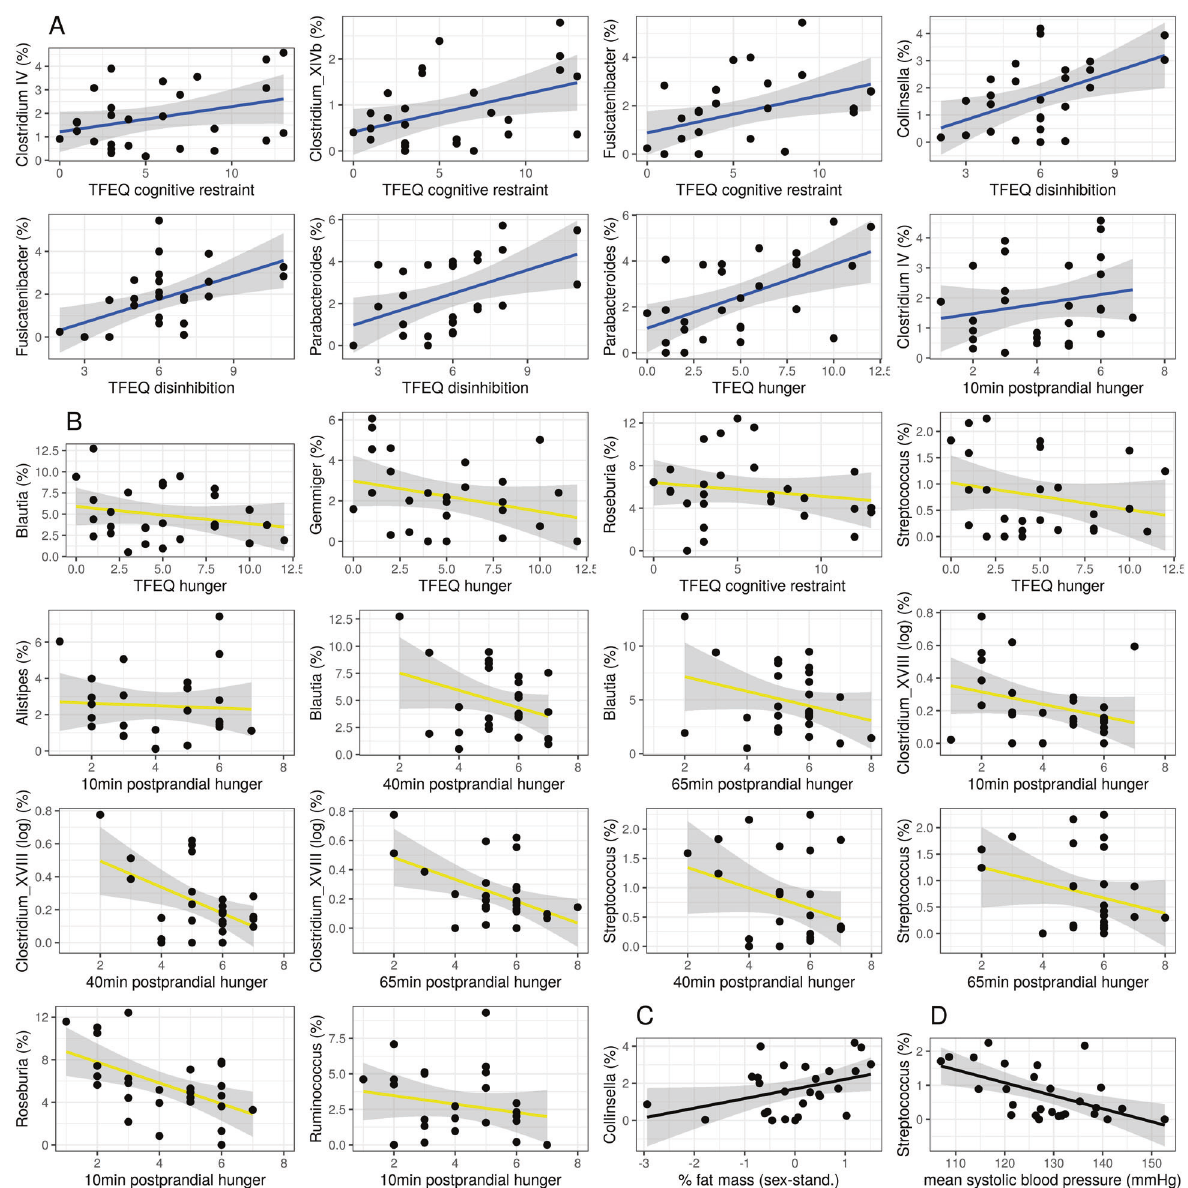
Fig. 2 Pearson ’ s correlations between eating behavior traits (TFEQ and hunger ratings) or health indicators and bacterial genera in overweight adults (all | r | > 0.42, all p-FDR < 0.05; sample 1). A inversely health-related genera (blue), B health-related genera (yellow), C Collinsella and body fat mass (black), and D Streptococcus and mean systolic blood pressure lower post-operative weight loss across both RYGB groups. Considering diet and SCFA-related pathways, we observed that higher dietary fi ber intake in overweight adults correlated with more abundant Clostridium XVIII , and less abundant Collinsella and Parabacteroides , as well as with healthier eating behavior and anthropometrics. While SCFA showed a rather mixed pattern of correlations with the different markers, Fusicatenibacter and Parabacteroides abundance correlated with higher fecal propio- nate and acetate, respectively, that again correlated with elevated hunger. Contrastingly, higher acetate and butyrate in serum correlated with lower fat mass, indicating a possible inverse association of acetate in feces and serum with respect to health indicators. Together, these results indicate that presumably bene fi cial and unfavorable microbiota genera relate to eating behavior and weight status, and that dietary fi ber intake and SCFA metabolism may modify these relationships.